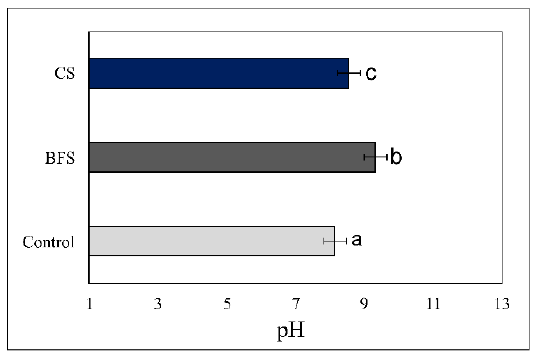
Figure 4. Soil pH under different treatment conditions (control, BFS, and CS).